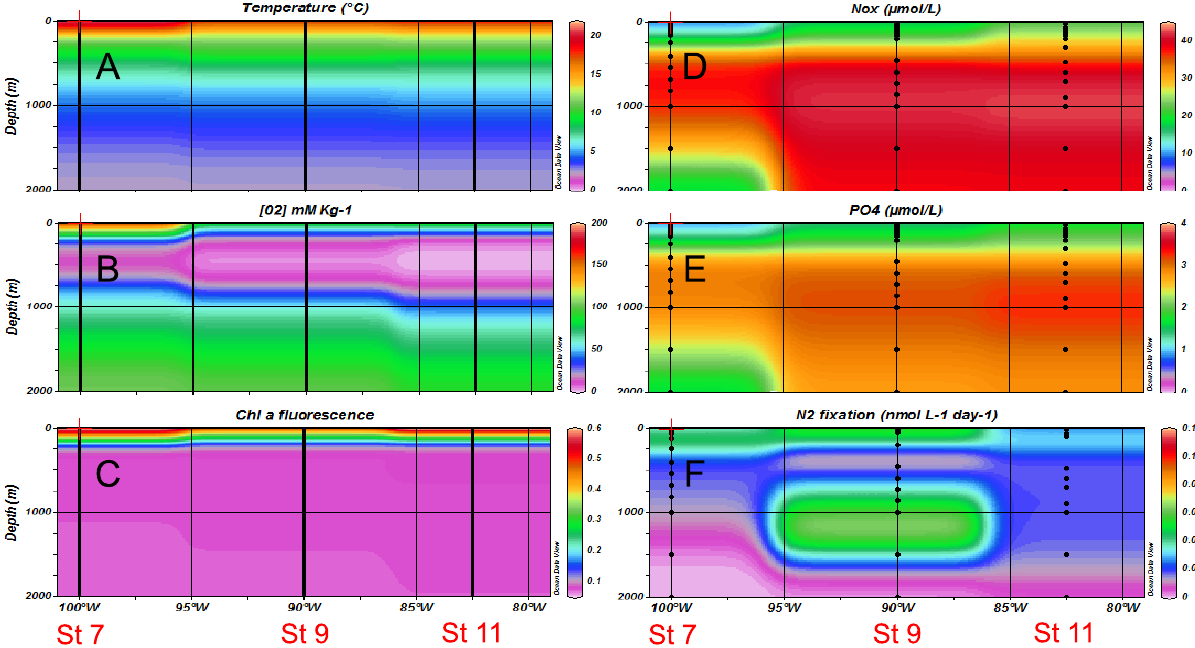
Figure 3. Horizontal and vertical distributions of hydrological and biogeochemical parameters during the 2011 cruise (R/V Melville) – Northern transect (10 6 S). (A) temperature, (B) dissolved oxygen, (C) chlorophyll a fluorescence, (D) NO 3 2 concentrations, (E) PO 43 2 concentrations, (F) Mean N 2 fixation rates (n=3).